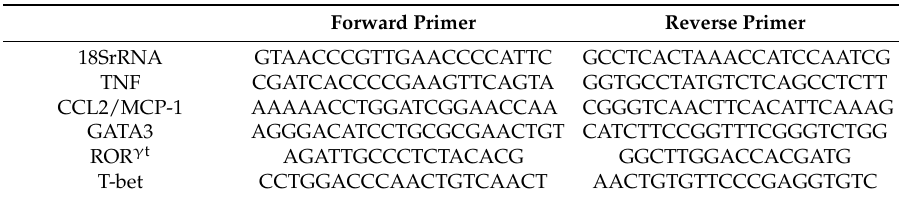
Table 4. Primer sequences for analysis of mRNA expression.